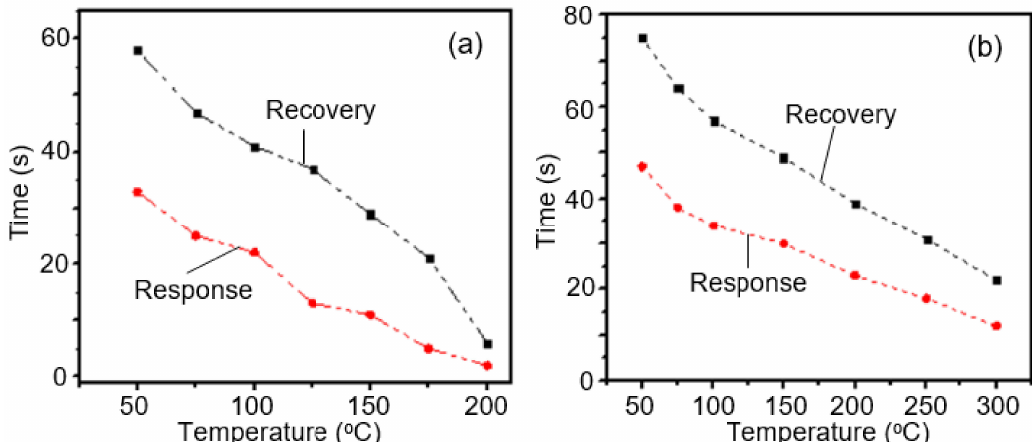
Figure 24. The response and recovery times of TiO 2 nanofiber sensor in 50 ppm hydrogen gas as a function of temperature ( a ) with UV and ( b ) without UV irradiation. Reprinted with permission from [141]. Copyright 2015